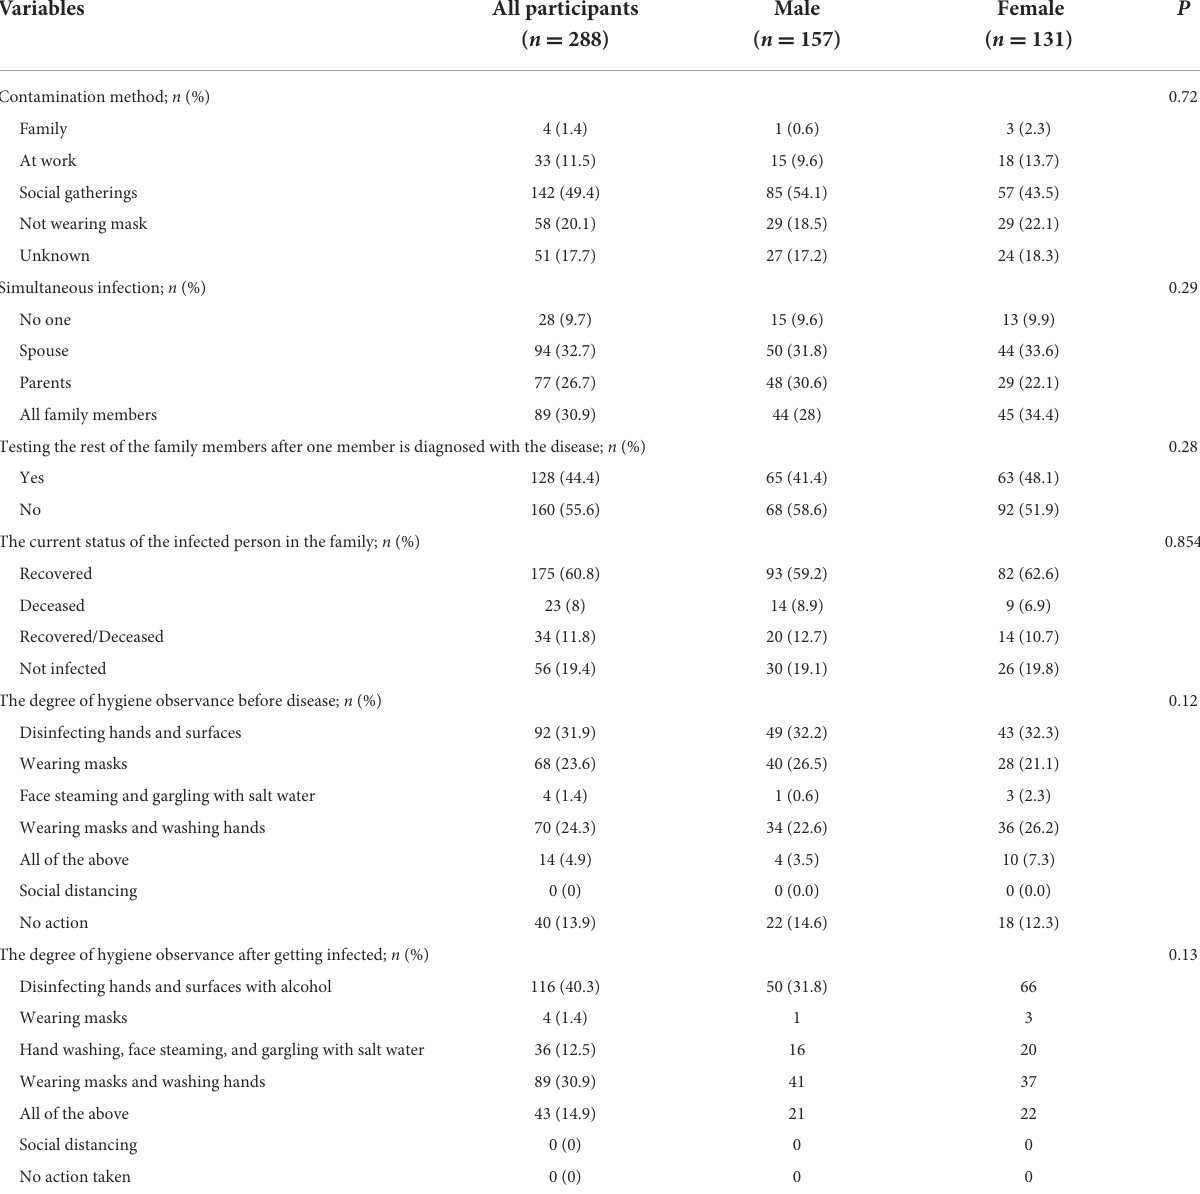
TABLE 2 Type of disease contamination and the degree of hygiene observance before disease and during home quarantine.